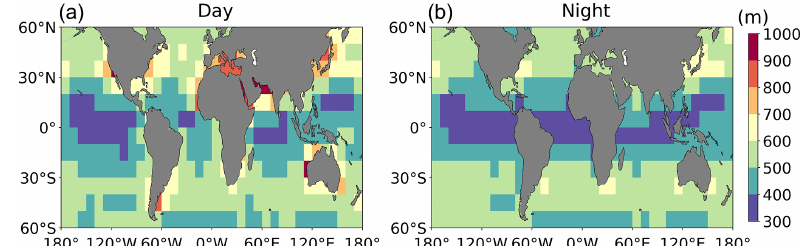
Figure 1. Marine atmospheric boundary layer height for the period of study estimated from GEOS-5 for daytime (a) and nighttime (b) .